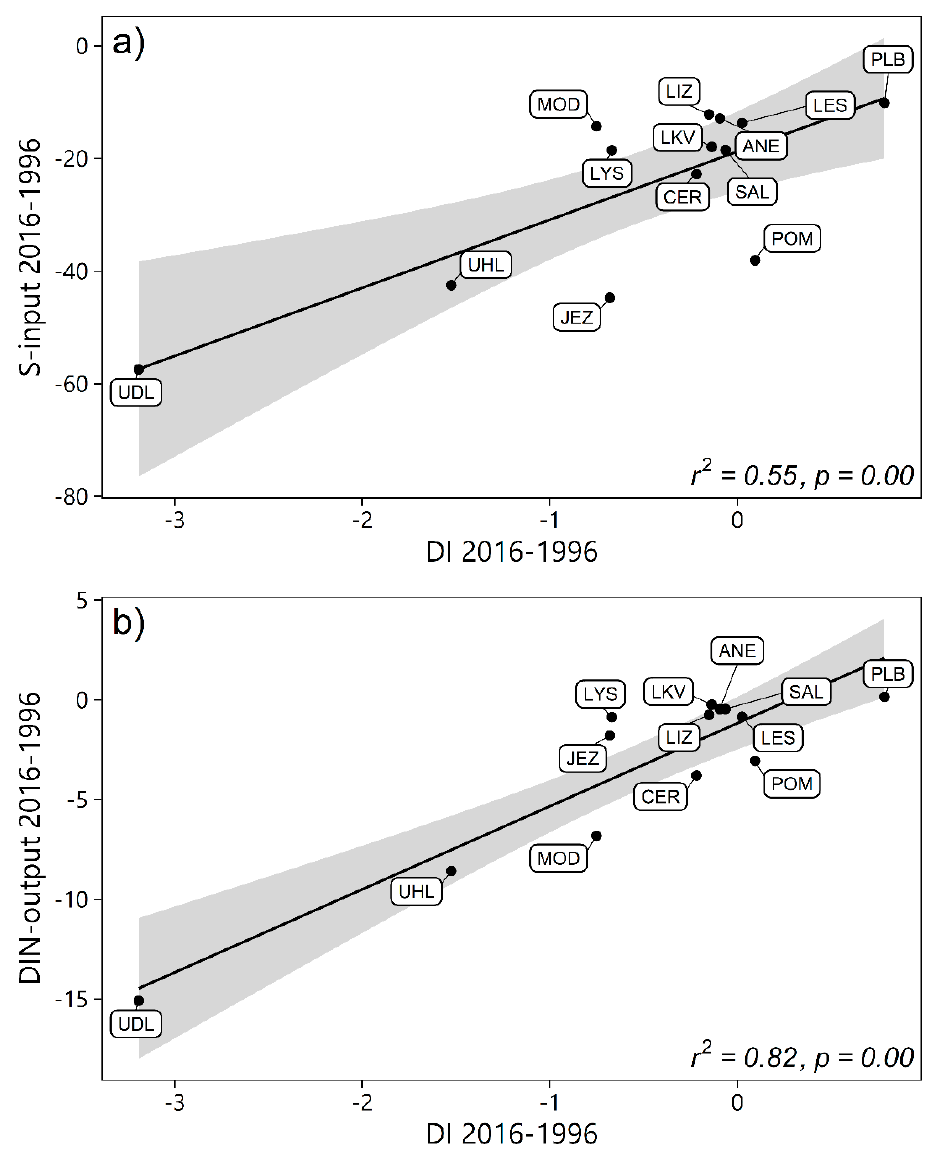
Figure 6. Linear relationships between changes from 1995 to 2016 in forest disturbance index (DI) and ( a ) total sulfur deposition (S-input), and ( b ) stream water dissolved inorganic nitrogen export (DIN-output). Bold lines show the linear trends, grey-shaded areas show 95% confidence level intervals. The coefficient of determination and p -values are included in the graph.